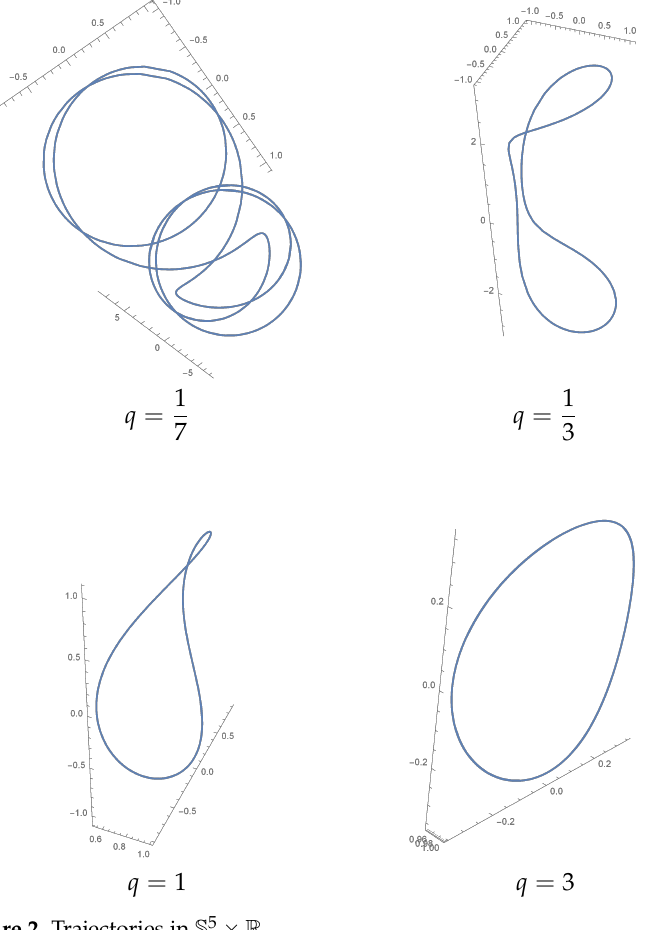
Figure 2. Trajectories in S 5 × R